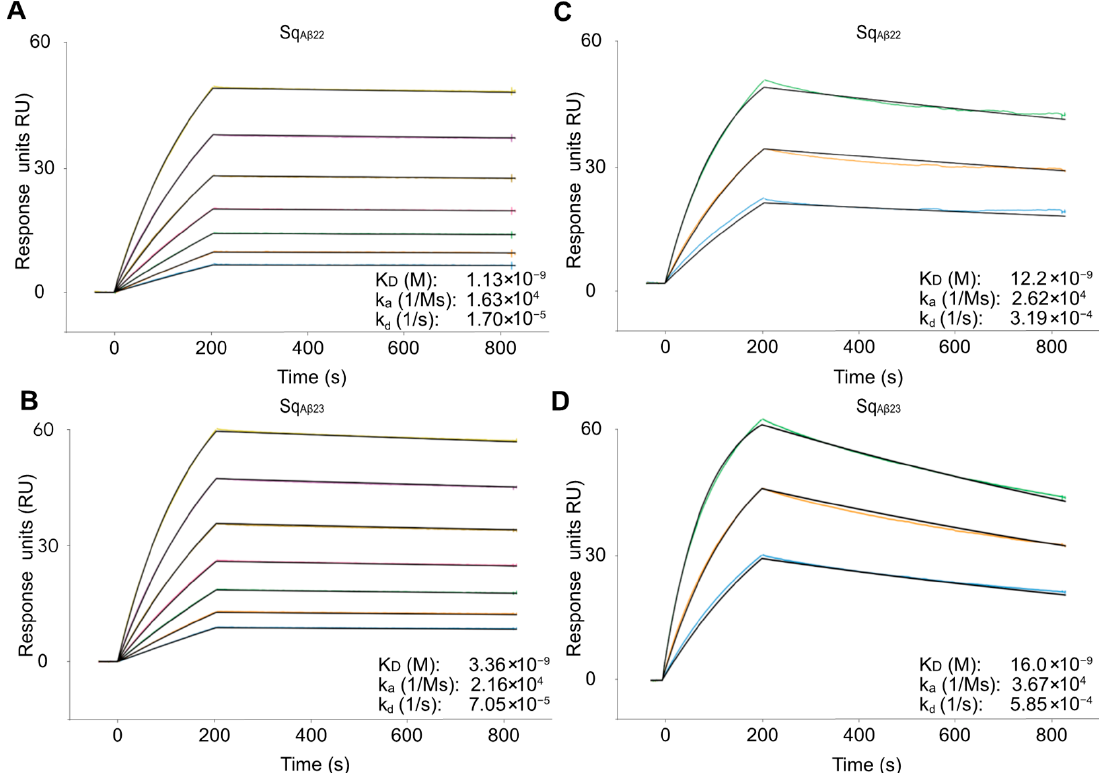
Figure 4. Surface plasmon resonance (SPR) sensorgram for the sequestrins Sq A β 22 , and Sq A β 23 at ( A , B ) 25 °C, and ( C , D ) 37 °C, respectively, and their corresponding kinetic constants. The y-axis shows the relative response units (RU) and x-axis time(s). Kinetics were recorded for 900 s, with analyte injection ending at 200 s. The sequestrins were injected in duplicate in a dilution series spanning 1:1.5 steps from 342 to 30 nM for the 25 °C affinity measurement. At 37 °C the sequestrins were injected in triplicates with concentrations 300–75 nM in a 1:2 dilution series. The black lines represent the fitting of the data to calculate kinetics. The experiment was conducted with immobilized A β 1–40 at a coating density of 80 RU.